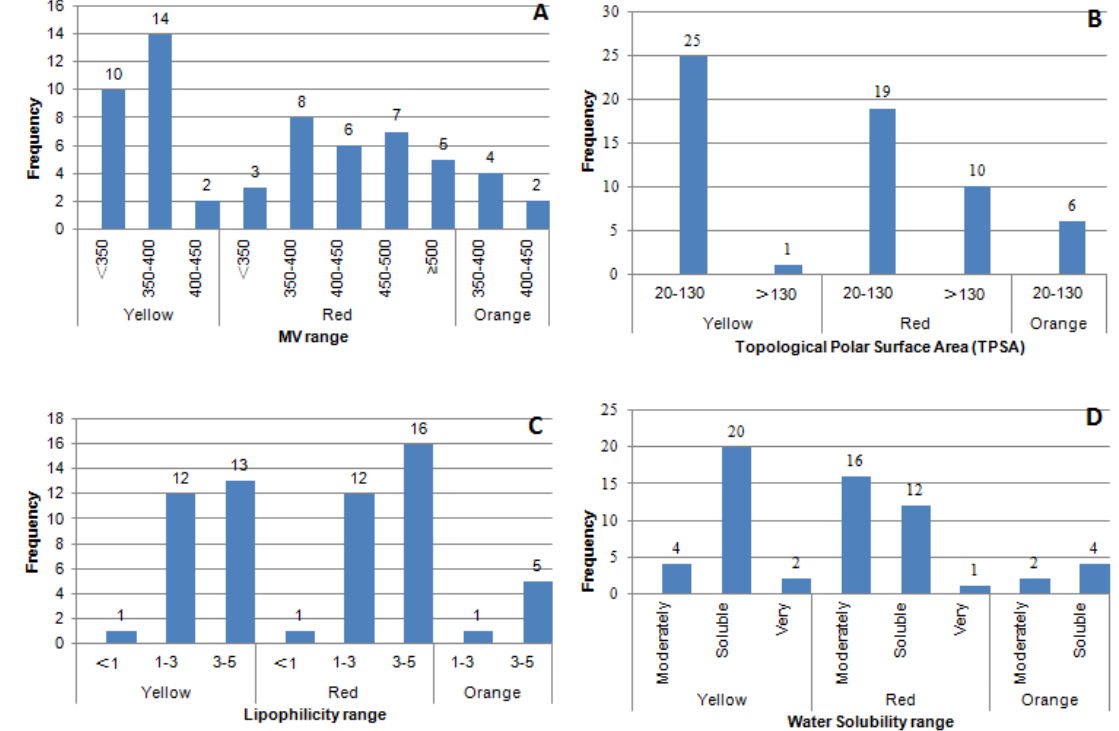
Figure 1. Distribution of physicochemical properties ( A ). molecular weight; ( B ). Topological polar surface area (TPSA); ( C ). Lipophilicity; ( D ). Water Solubility) of the Monascus pigments.